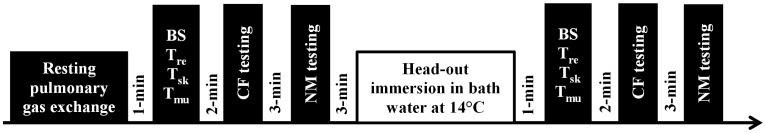
Research design.BS – blood samples, Tre – rectal temperature, Tmu – muscle temperature, Tsk – skin temperature. Cognitive function (CF) testing involved the unpredictable task switching test (executive function), the forward digit-span task test (short term memory), and the forced-choice recognition memory test (short term spatial recognition). Neuromuscular (NM) testing involved evaluation of spinal (H-reflexes, M-waves) and supraspinal (V-waves) excitability, evaluation of muscle contractility characteristics induced by a 1-s electrical stimulation at 1 Hz, 20 Hz, 100 Hz and TT-100 Hz; evaluation of maximal voluntary contraction torque and central activation of exercising muscle was performed with a TT-100 Hz superimposed stimulation on the maximal voluntary contraction. Intermittent head-out immersion in bath water at 14°C continued until the rectal temperature decreased to 35.5°C or until 170 min total (120 min maximum total immersion time), at which time the immersion ended regardless of the rectal temperature.